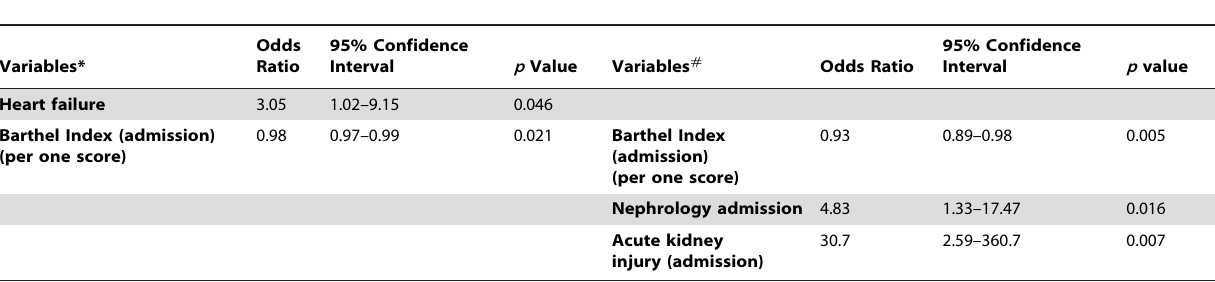
Table 5. Multivariate logistic regression analysis of the predictors of hospitalization duration and in-hospital mortality in nonagenarians, with stepwise selection of variables (n